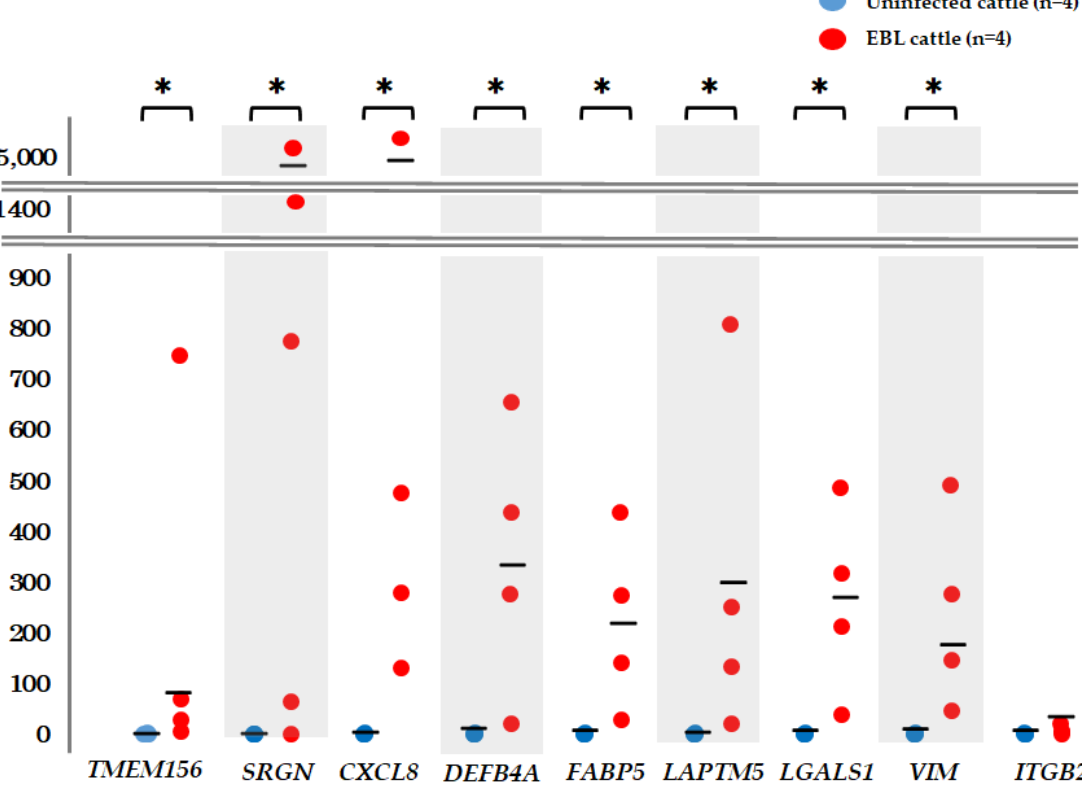
Figure 3. Relative quantities of mRNA in milk sEVs of cattle by microarray analysis. Of the selected 14 mRNAs detected by microarray analysis, 9 were validated by qPCR, namely TMEM156 , SRGN , CXCL8 , DEFB4A , FABP5 , LAPTM5 , LGALS1 , VIM , and ITGB2 . The mean of relative quantities of mRNA is shown as a horizontal bar. (*, p <